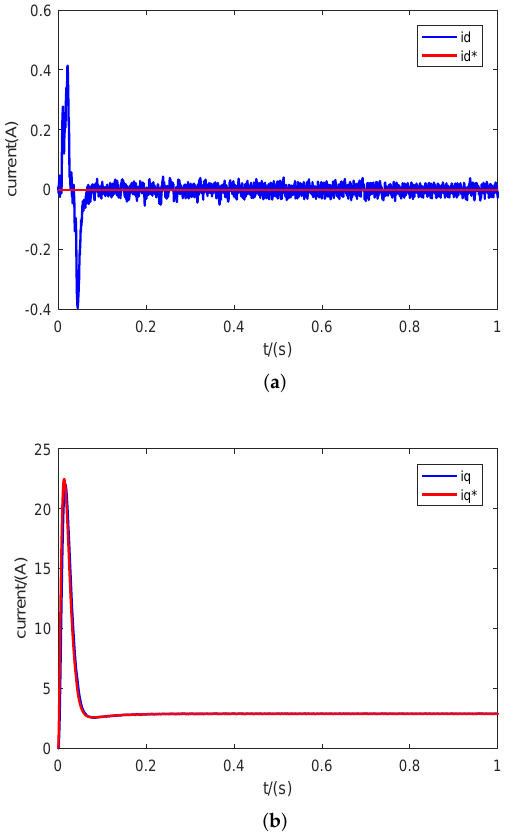
Figure 9. Simulation results with the proposed method under the parameter disturbance: ( a ) d-axes current and ( b ) q-axes